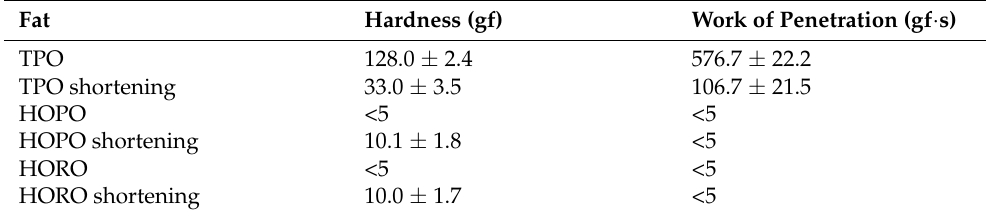
Table 5. Hardness (gf) and work of penetration (gf · s) of produced shortenings. Fat Hardness (gf) Work of Penetration (gf · s) TPO 128.0 ± 2.4 576.7 ± 22.2 TPO shortening 33.0 ± 3.5 106.7 ± 21.5 HOPO <5 <5 HOPO shortening 10.1 ± 1.8 <5 HORO <5 <5 HORO shortening 10.0 ± 1.7